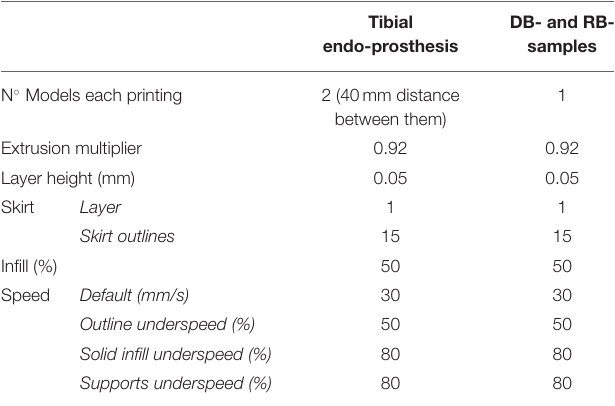
TABLE 1 | Characteristics of FDM printings at Simplify 3D slicer. DB- and RB- samples, are tensile test and bending test samples.